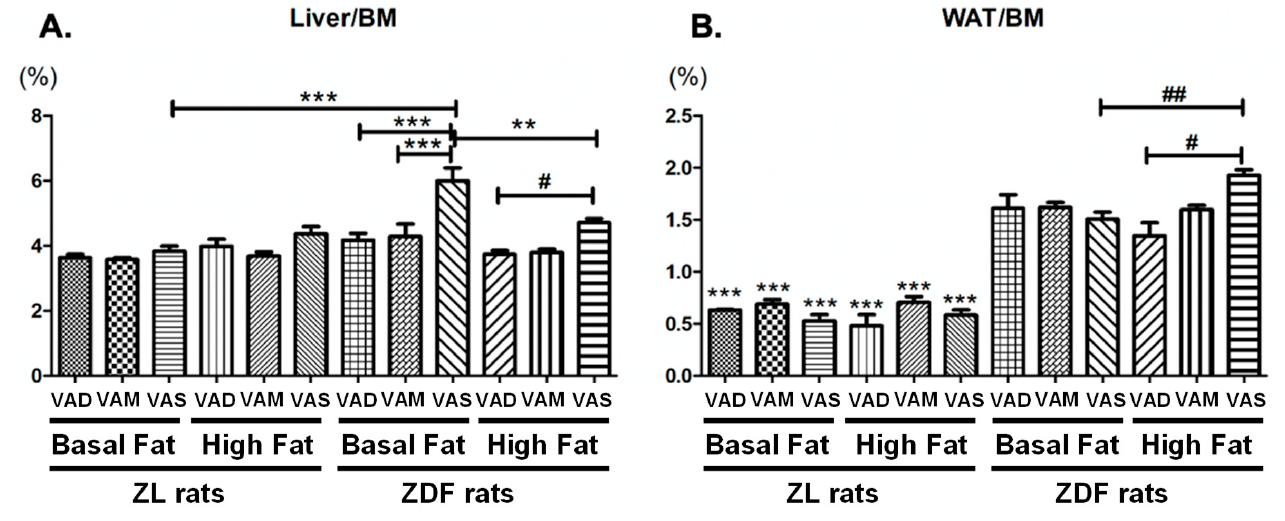
Figure 4. The ratios of liver/BM (A) and WAT/BM (B) were calculated and compared between VAD/VAM/VAS-BF/HF ZL and ZDF rats. The ratios of liver/BM and WAT/BM were calculated and compared. Data are represented means ± SEM, n = 5–6 per group. For the liver/BM, ** p < 0.01, *** p < 0.001 VAS-BF ZDF rats vs. other groups; # p < 0.05, ## p < 0.01 VAS-HF ZDF rats vs. other groups. For the WAT/BM, ** p < 0.01, *** p < 0.001 ZL rats vs. ZDF rats in same diet; # p < 0.05, ## p < 0.01 VAS-HF ZDF rats vs. other groups. As shown in Figure 4B, the WAT/BM ratios of ZDF